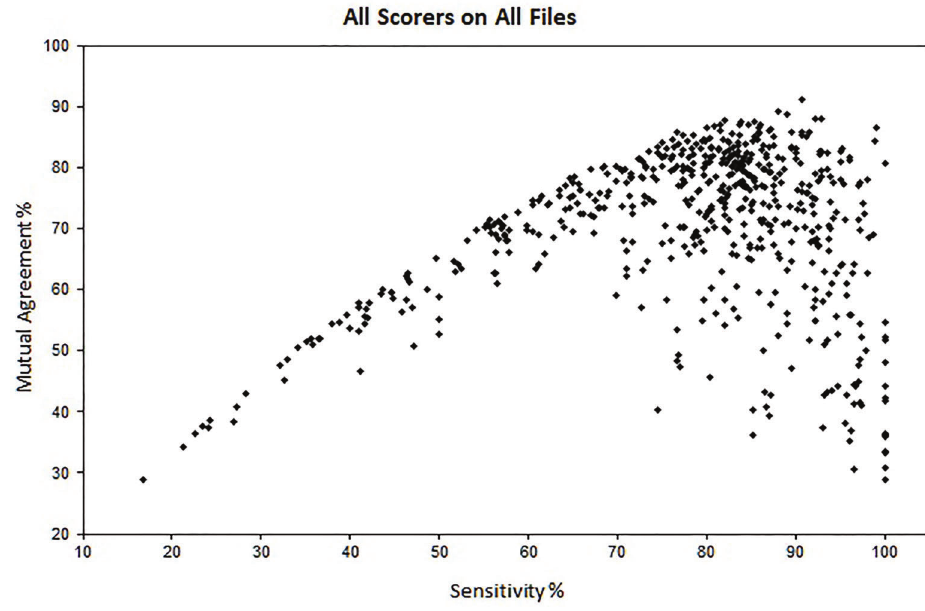
Figure 3. Mutual agreement scatter plot versus sensitivity for all pairwise fi le-by- fi le comparisons. This graph shows high density values in 80% neighborhood.